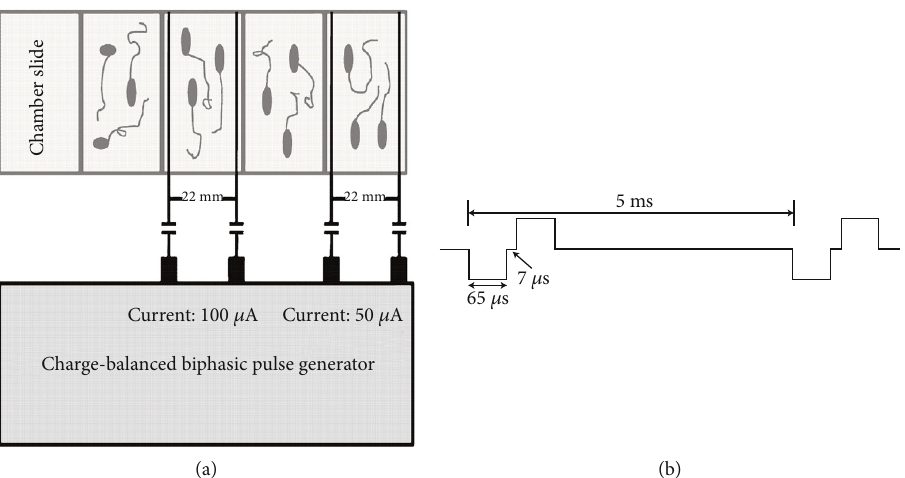
Figure 1: The cultured spiral ganglion neurons (SGNs) are treated with charge-balanced biphasic electrical stimulation. (a) Four-well chamber slides were used in this culture system. Four holes adjacent to the fl oor were made on two opposite walls of each chamber to introduce two platinum-iridium wires at the two opposite borders. The wires were connected to charge-balanced biphasic pulse generators. (b) The biphasic pluses used for the electrical stimulation were 50 μ A or 100 μ A amplitude, 65 μ s pulse width, 8 μ s open-circuit interphase gap, 4862 μ s short-circuit phase, and 200Hz